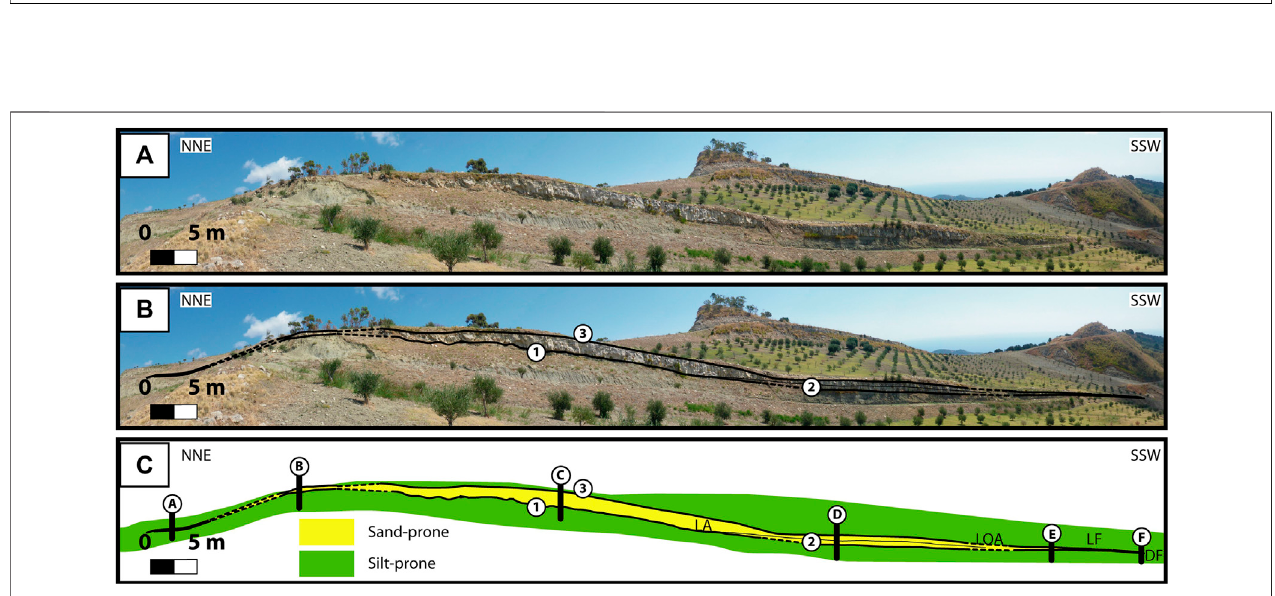
FIGURE 11 | Panoramic view of the Di Leo area illustrating the isolated detached lobe architecture. The main surface discussed in the text (1 – 3) is highlighted. Sedimentologicalsections (A – F) andinterpretationarepresentedin Figure12 .Channel(C)faciesassociationispreservedupdipoftheLobeaxis(LA)faciesassociation. (C) Channel, (LA) Lobe axis, (LOA) Lobe off-axis, (LF) Lobe fringe, (DF) Distal lobe fringe.